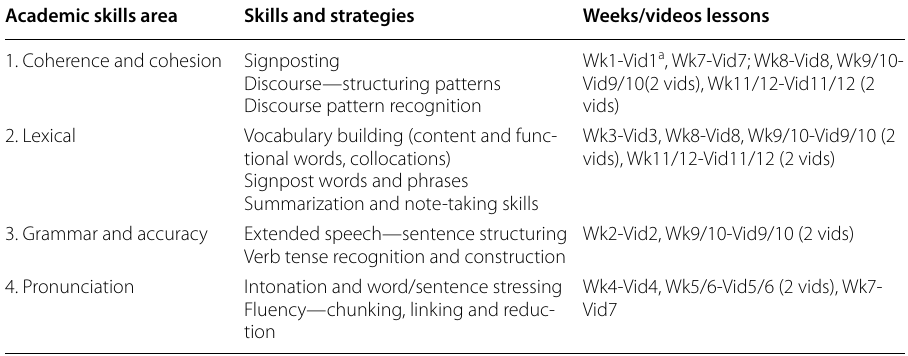
Table 1 TC/RFG/PFG instructional course